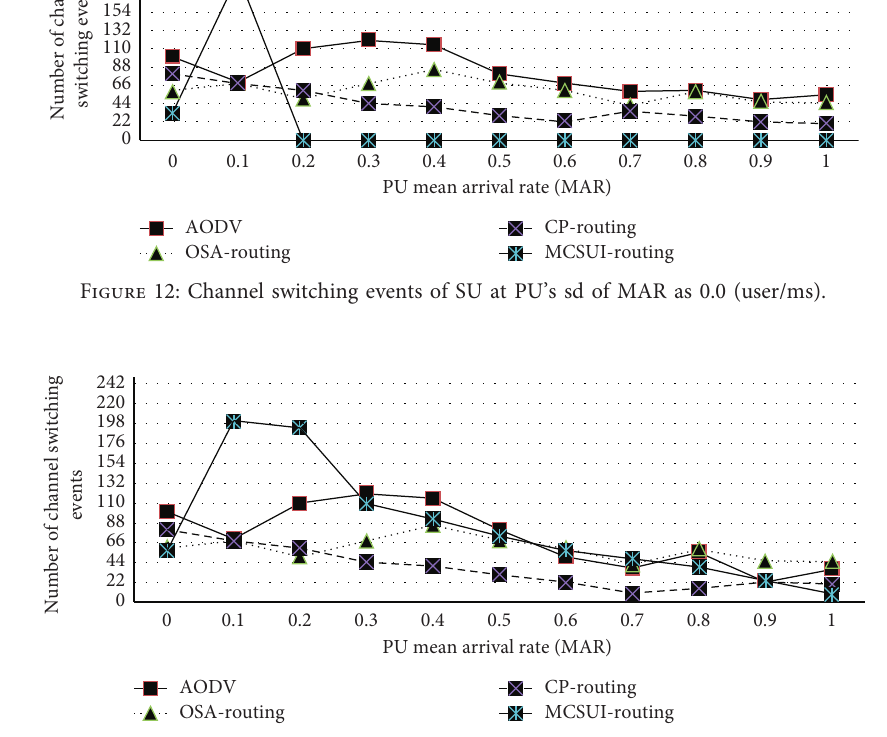
Figure 13: Channel switching events of SU at PU’s sd of MAR as 0.4 (user/ms).